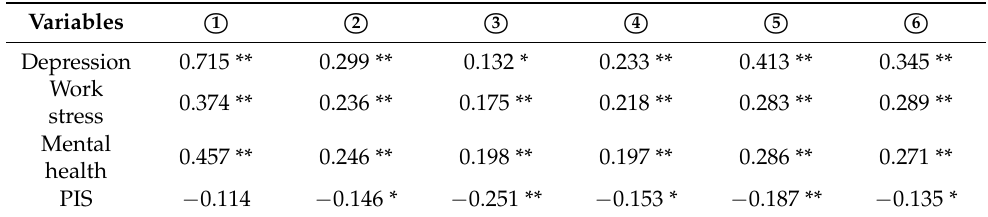
Table 8. Correlation analysis